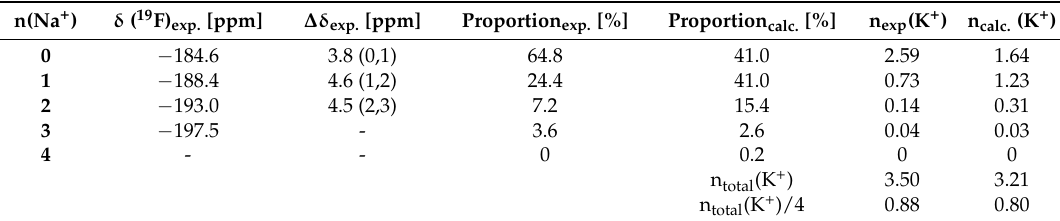
Figure 8. XRDs of annealed xerogels 9, 13 – 17 , pdf x=0 : 18-1033, star, pdf x=1 : 81-952.